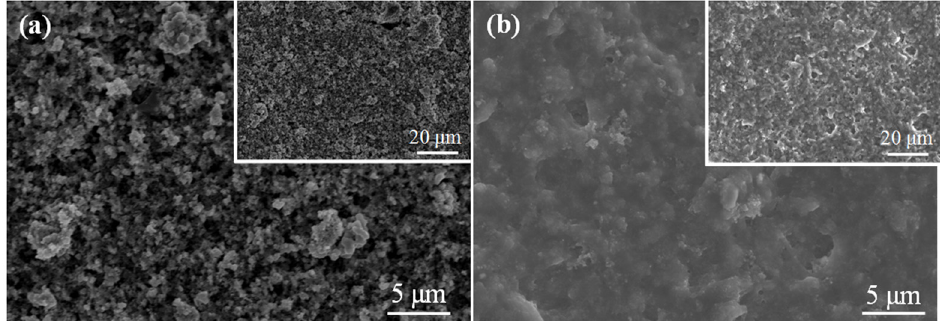
Figure 7. SEM after 200 cycles of ( a ) SnO 2 and ( b ) SnO 2 /CNT NNs electrode.